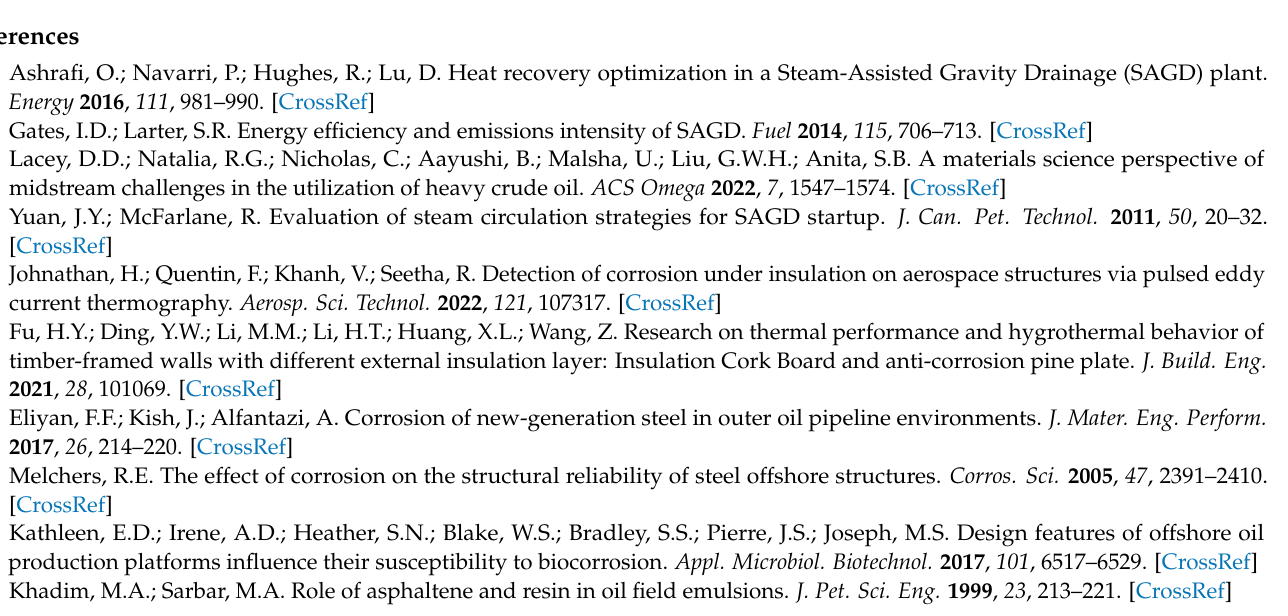
Figure S2: The contact angels of SiO 2 aerogel power before (left) and after (right) modification, Figure S3: Microstructure of fiber reinforced SiO 2 aerogel thermal insulation coating: (a) internal metallographic diagram of coating; (b) internal metallographic diagram of coating; (c) internal SEM of coating, Figure S4: The mages of the samples after the pull-off test. (a) P/B = 3:1, (b) P/B = 2:1, (c) P/B= 1:1, (d) P/B = 1:2, (e) P/B = 1:3, Table S1: Thermal insulation coating